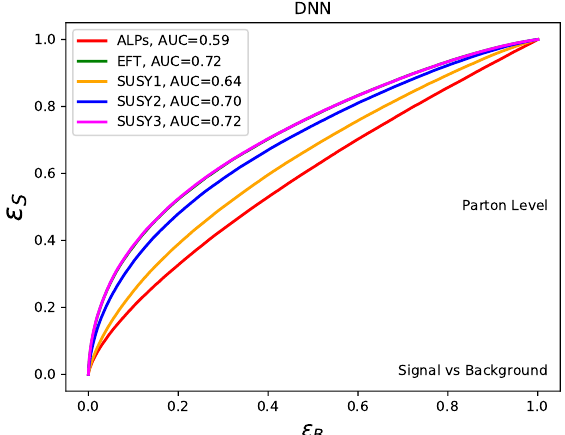
Figure A3: ROC curves using Neural Networks for different signals versus back- ground for the monojet parton-level analysis.